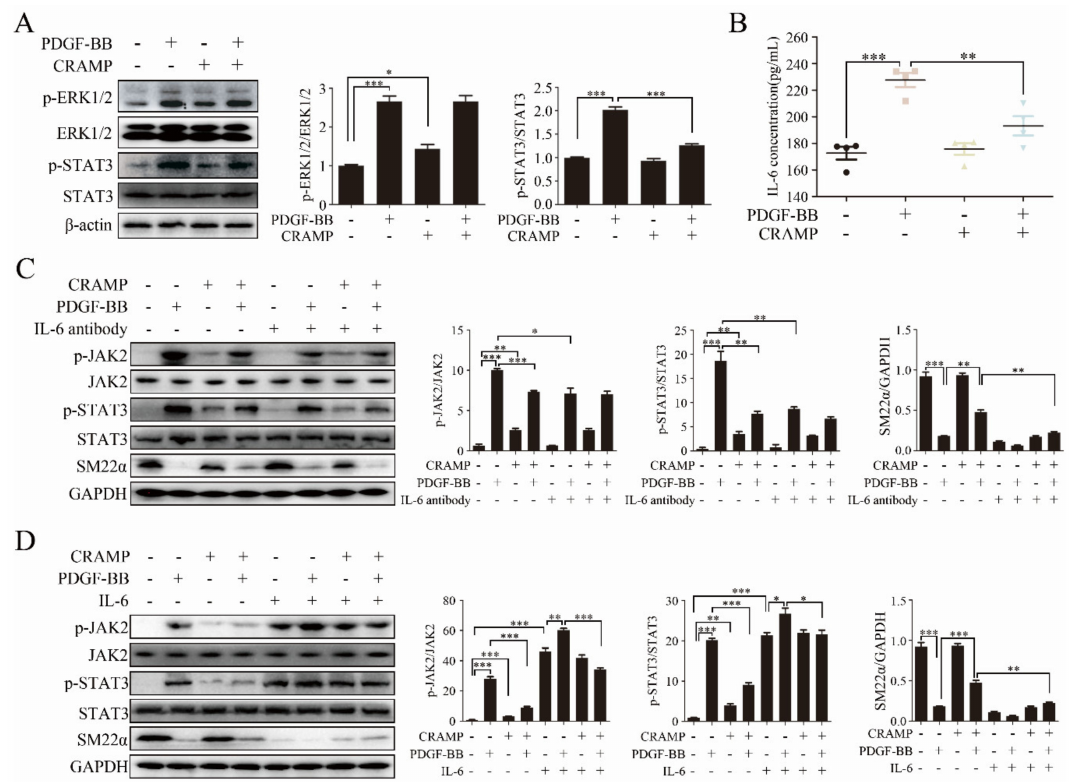
Figure3. IL-6 / JAK2 / STAT3cascadesparticipatedinCRAMPinhibitedVSMCPhenotypictransformation. ( A ) VSMC were pretreated with CRAMP (100 ng / mL) for 2 h and then stimulated with PDGF-BB (20 ng / mL) for 24 h. The activation of ERK1 / 2 and STAT3 was detected using immunoblotting with anti-p-ERK1 / 2, anti-STAT3 antibodies. Data of 3 independent experiments is presented as mean ± SEM. * p < 0.05, *** p < 0.001 compared with control, n = 3. ( B ) VSMC were pretreated with CRAMP (100 ng / mL) for 2 h and then stimulated with PDGF-BB (20 ng / mL) for 24 h. IL-6 in culture medium was detected by enzyme-linked immunosorbent assay (ELISA). Data of 3 independent experiments is presented as mean ± SEM. *** p < 0.001 compared with control, n = 4. ( C ) VSMC were pretreated with IL-6 antibody (10 µ g / mL) for 2 h and CRAMP (100 ng / mL) for 2 h and then stimulated with PDGF-BB (20 ng / mL) for 24 h followed by immunostaining with p-JAK2, p-STAT3 and SM22 α antibodies. ( D ) VSMC were pretreated with recombinant IL-6 at final concentration of 10 ng / mL and CRAMP (100 ng / mL) for 2 h and then stimulated with PDGF-BB (20 ng / mL) for 24 h followed by immunostaining with p-JAK2, p-STAT3 and SM22 α antibodies. Data of 3 independent experiments is presented as mean ± SEM. ** p < 0.01, *** p < 0.001 compared with control, n =